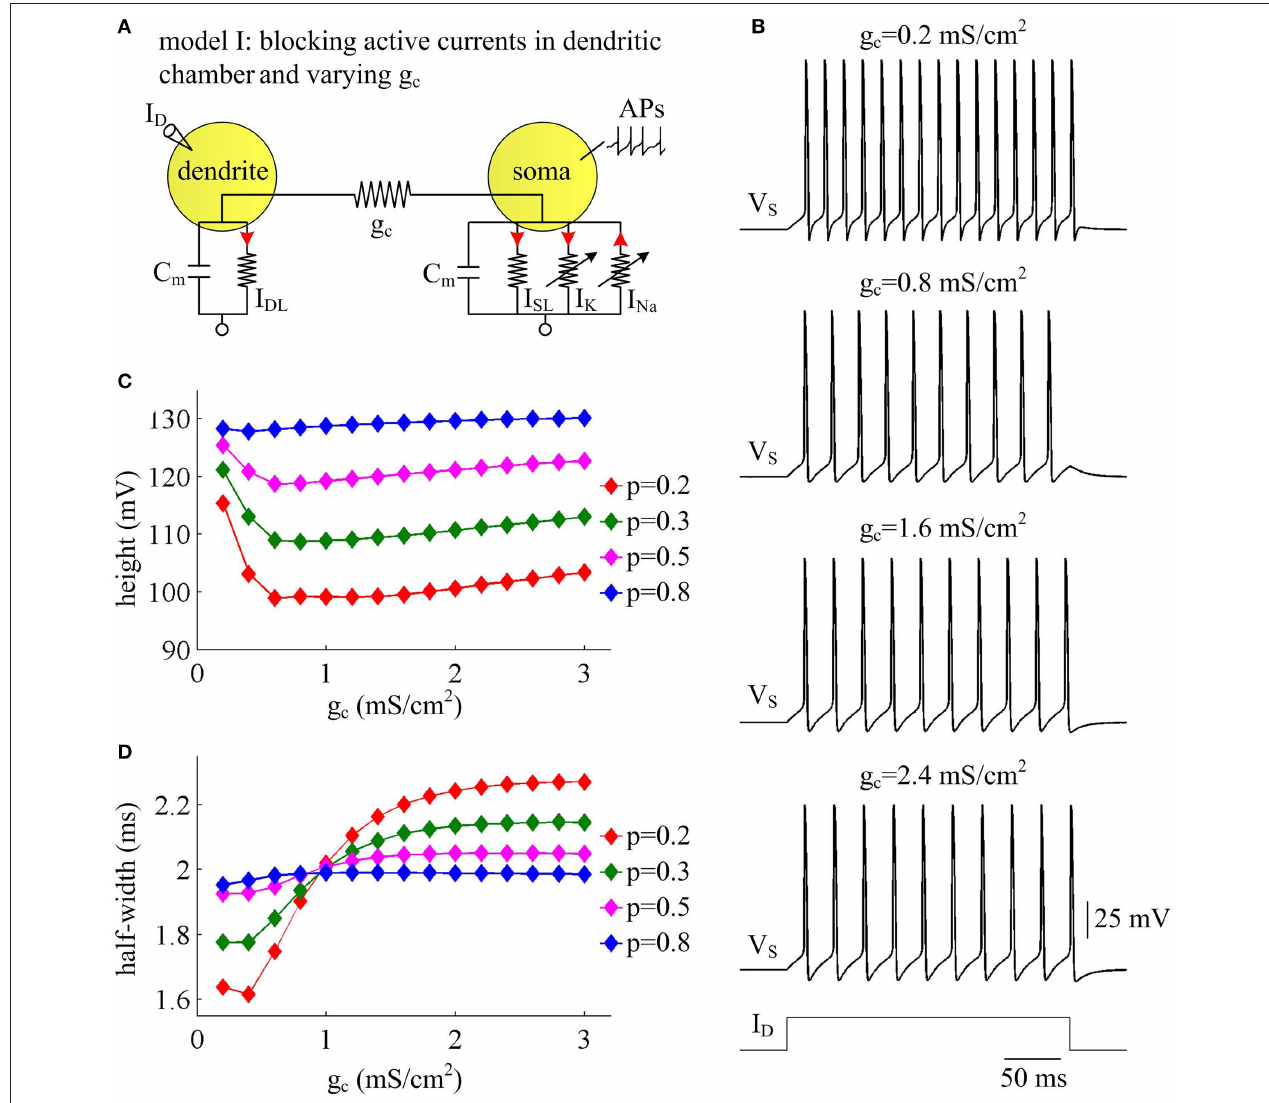
FIGURE 3 | AP shape varies with coupling conductance between chambers in model I. (A) We vary coupling conductance g c in model I with passive dendrite. (B) Sample responses recorded in the soma with different values of g c , which are indicated on the top of each panel. Data are shown for p = 0.5. (C) The height of the AP is plotted as a function of g c for different values of p , which are 0.2, 0.3, 0.5, and 0.8. (D) The half-width of the AP is plotted as a function of g c for each value of p . Dendritic input is I D = 2 µ A / cm 2 . Note that the height and half-width for individual spike in (C,D) are different from those with same values of p and g c in Figure 1C . This arises from that stimulus input I D used in the case of varying dendrite area is 3 µ A / cm 2 . Such higher current injection directly controls the excitability of two-compartment models and alters the shape of output